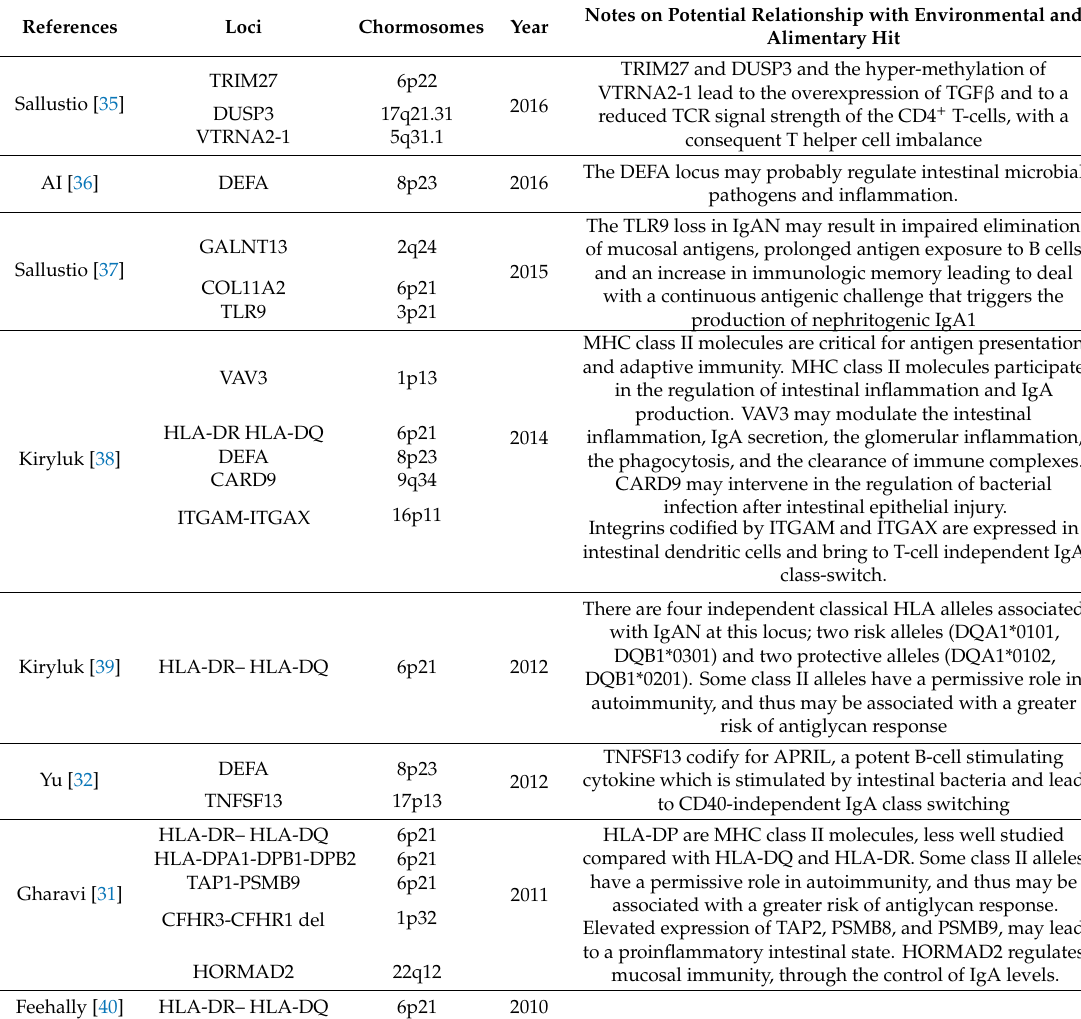
Table 1. Evidence of Potential Relationship with Environmental and Alimentary Hit in